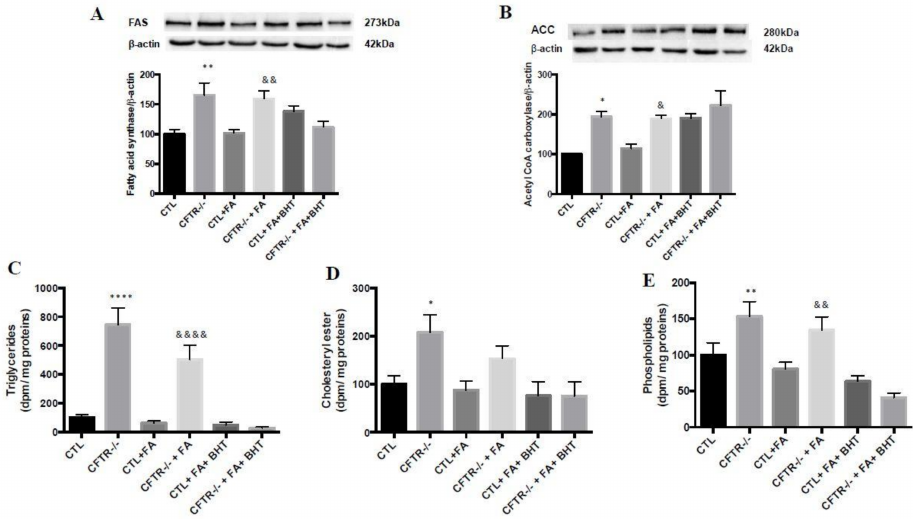
Figure 7. Influence of CFTR deletion on lipogenic enzymes and lipid synthesis. At the end of 15 days of differentiation, Caco-2/15 cells were harvested, trypsinized, and homogenized. Protein mass of ( A ) fatty acid synthase (FAS) and ( B ) acetyl CoA carboxylase (ACC) was analyzed by western blotting. Following a challenge cells with ( 14 C)-oleic acid, lipid synthesis was assessed by quantification of ( C ) triglycerides, ( D ) cholesteryl ester and ( E ) phospholipids in basolateral medium. Values are means ± SEM of 3 independent experiments, each performed in triplicate. * p < 0.05, ** p < 0.01, **** p < 0.0001 vs. CTL cells; & p < 0.05, && p < 0.01, &&&& p < 0.0001 vs. CTL + FA cells. CTR: control cells; FA: iron/ascorbate (200 µ M/0.5 mM); BHT: Butylated hydroxy toluene (0.5 mM).